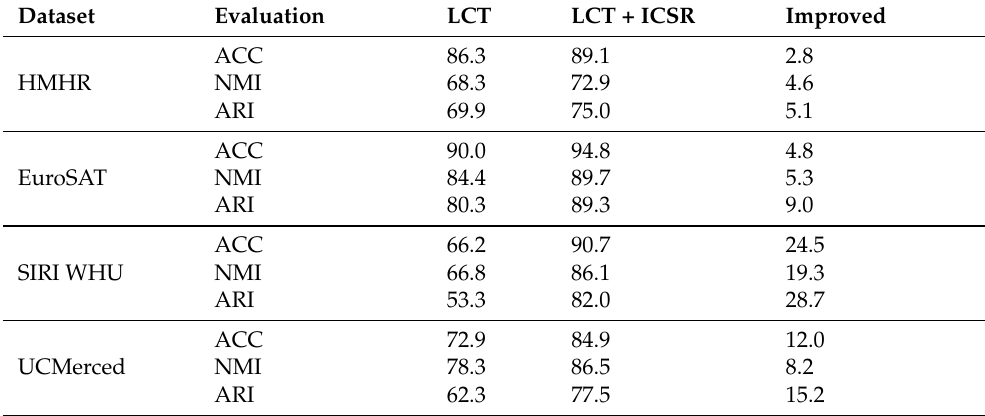
Table 7. The clustering performances by our method for 7 datasets of remote sensing images.